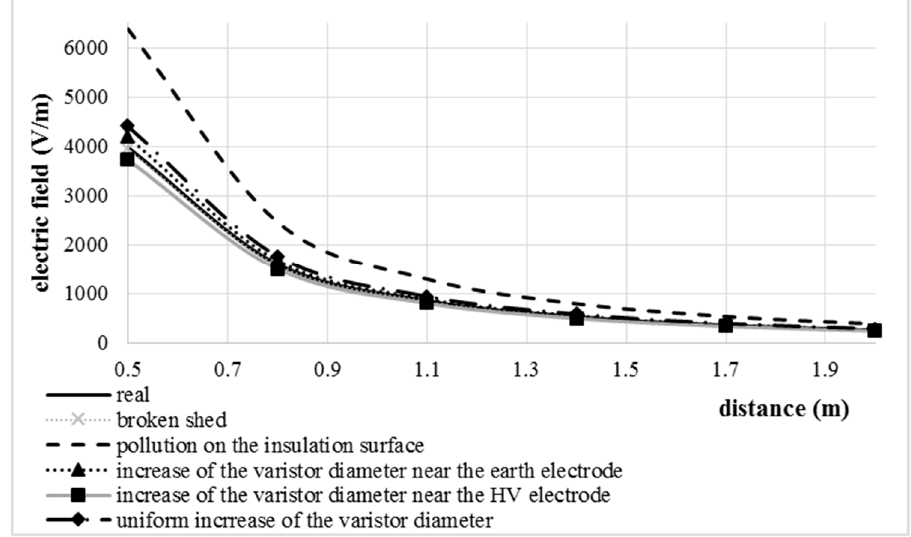
Figure 17. Electric field (V/m) in function with the distance from the arrester (height from the earth electrode equal to 29 cm).